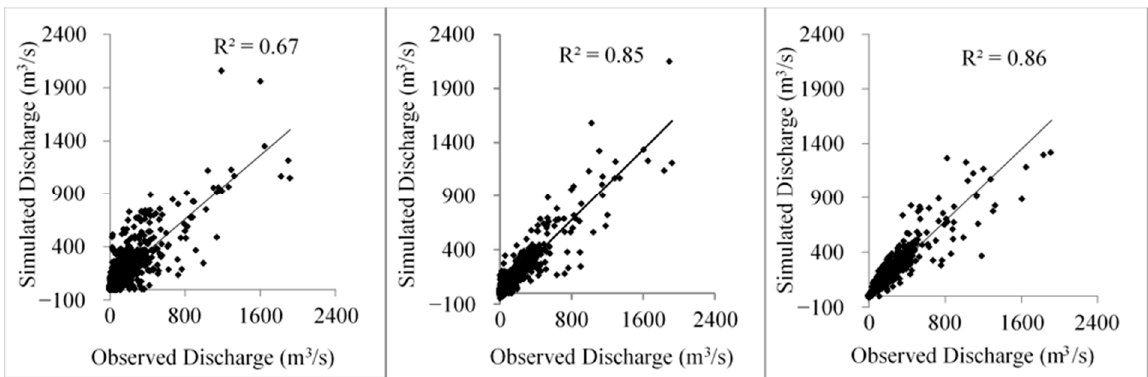
Figure 13. Scatter plot of daily simulated and observed discharge for SWAT ( left ), ARX ( middle ), and GEP ( right ) during the validation period (2008–2010) at LD10.